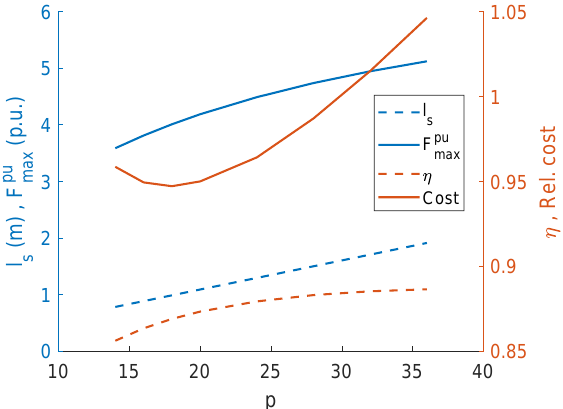
Figure 7. Stator length, maximum damping force in per unit, efficiency and relative cost for the original generator design with varied number of poles, p and an adjusted stator length, l s to achieve an output power of 18.4 kW.